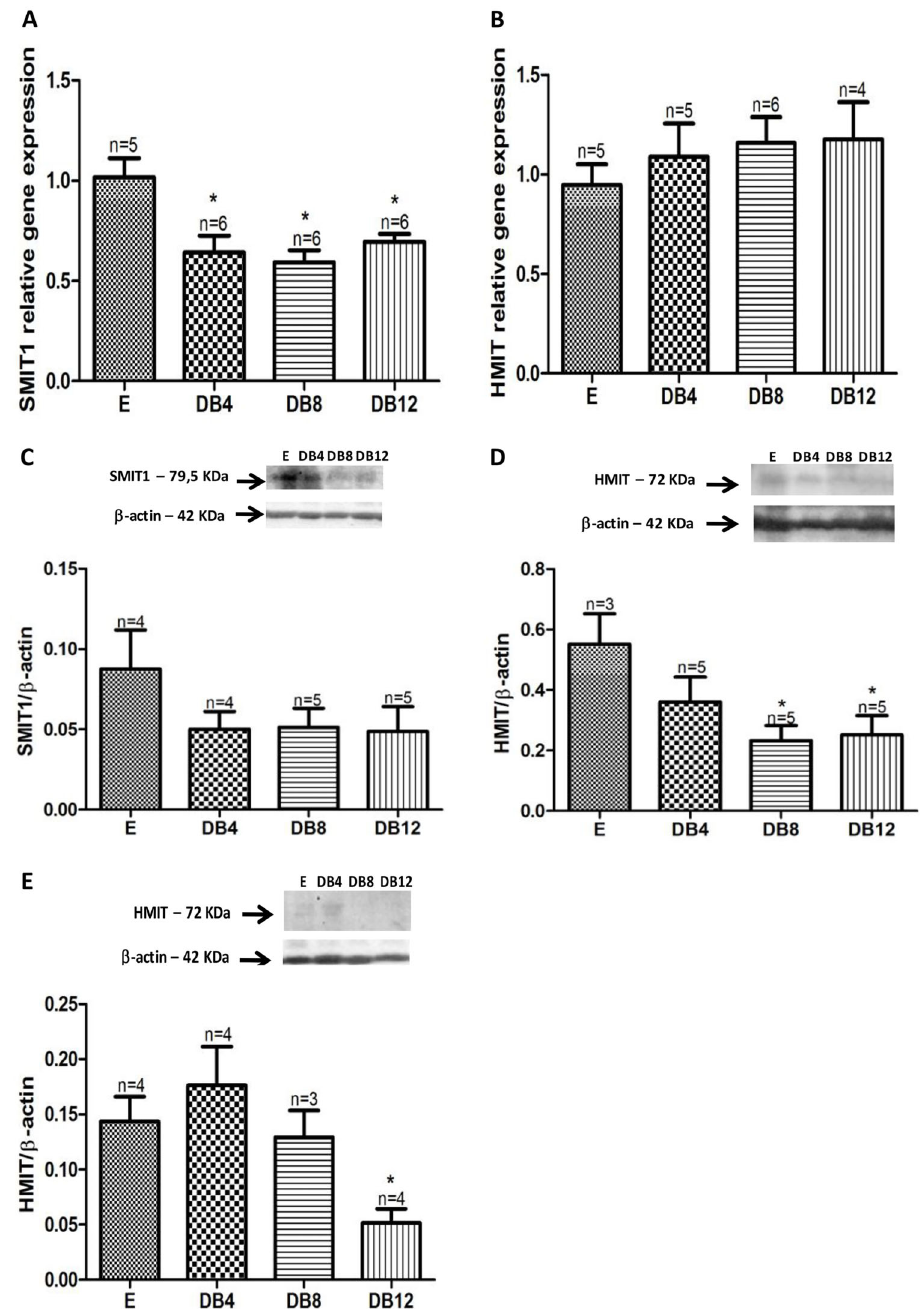
Figure 3. Relative quantitative mRNA expression of the sodium myo-inositol cotransporter (SMIT1) and H + /myo-inositol cotransporter (HMIT) in the sciatic nerve ( A , B ) of 4, 8, and 12 week diabetic rats (DB4, DB8, DB12, respectively). C , SMIT1 protein expression in the sciatic nerve membrane fraction in diabetic rats compared to euglycemic rats (E) rats. HMIT protein expression in the sciatic nerve cytoplasmic ( D ) and membrane fraction ( E ) in diabetic rats compared to E. b -actin detection was used as loading control. Data are reported as means ± SE. *P o 0.05 vs E (Student ’ s t